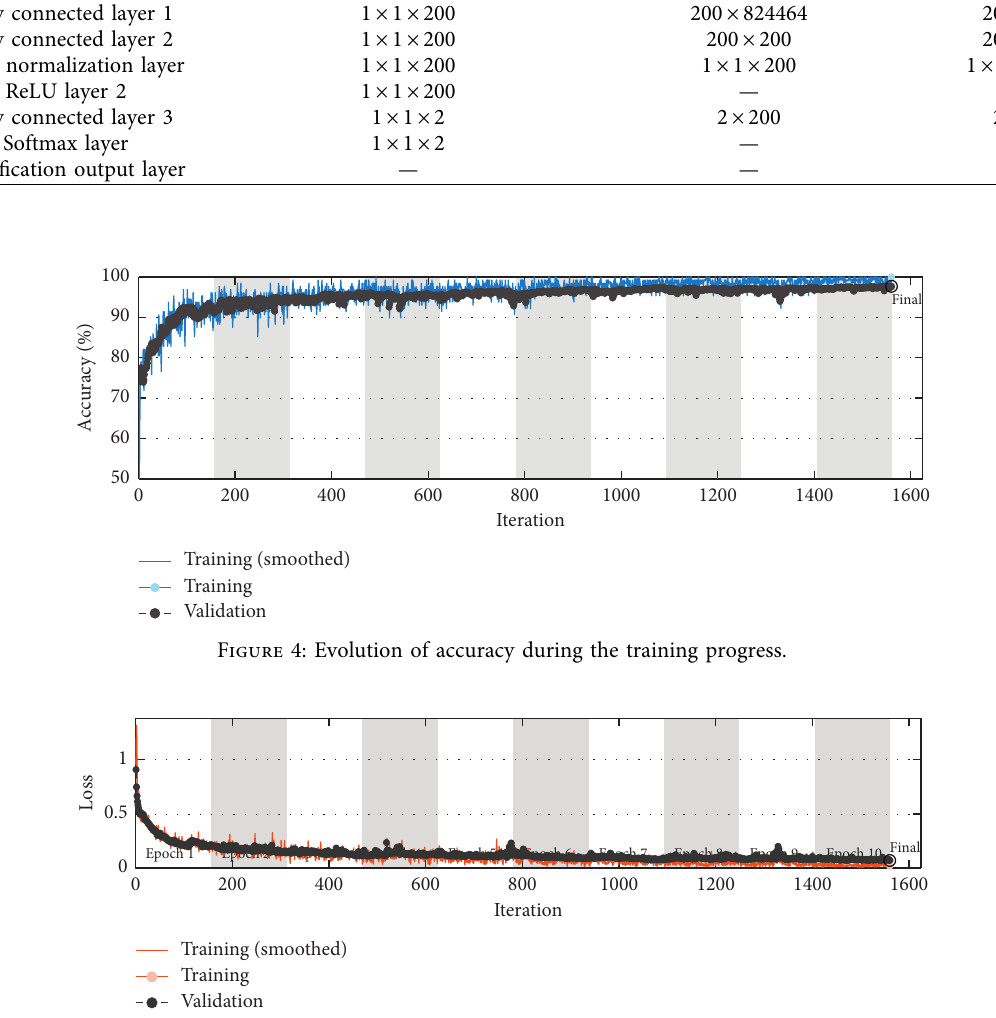
Figure 5: Evolution of loss during the training